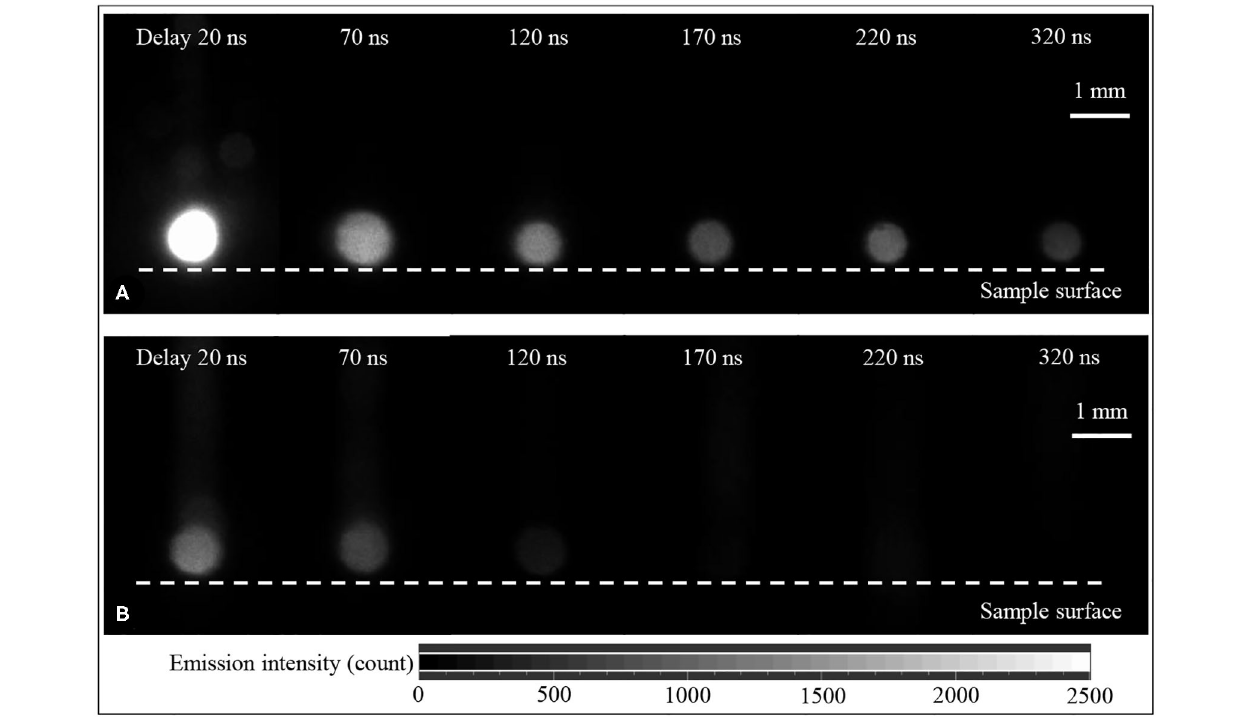
Frontiers in Physics |